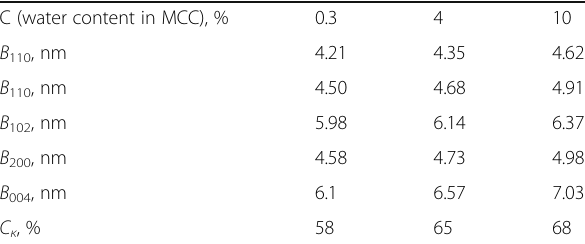
Table 3 Transversal dimensions of crystallites B hlk and degree of crystallinity C k for the samples of MCC with different content of water